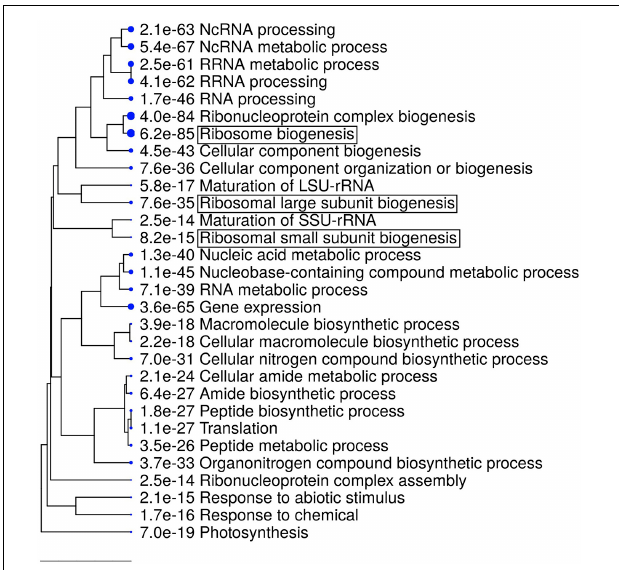
FIGURE 5 | Gene ontology (GO) enrichment analysis of upregulated differentially expressed genes (DEGs) in rdp1 compared with the wild-type (1284 genes). The top 30 hits on the GO list are shown in this figure, and the top 500 hits in the GO data are listed in Supplementary Table 3 . Hierarchical clustering tree summarizing the correlation among the significant pathways listed in the Enrichment tab. Larger dots indicate smaller P -values. GO terms containing “ribosome” are highlighted by